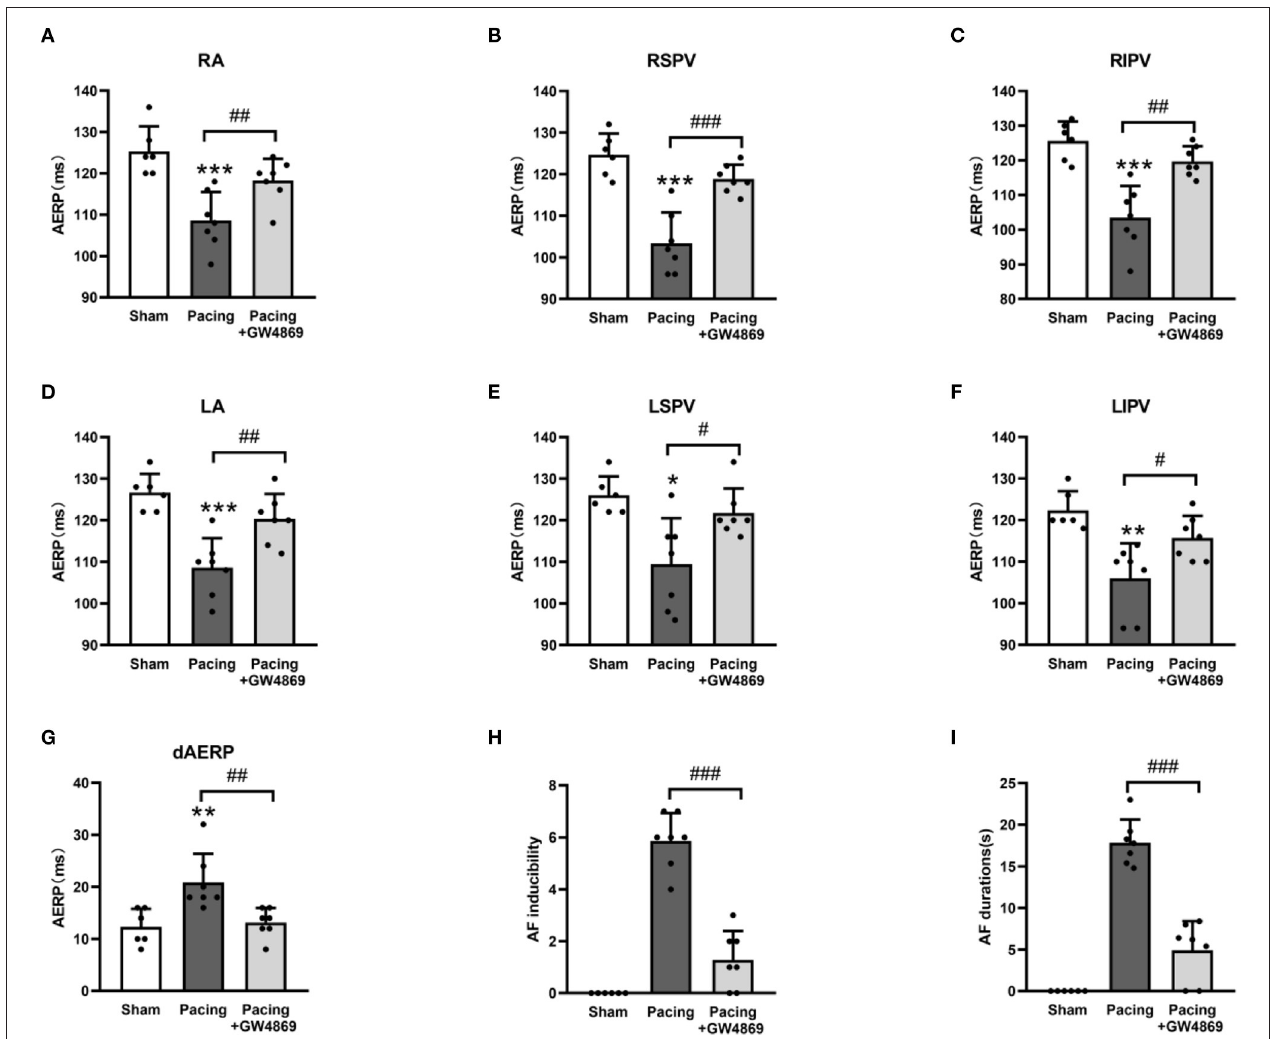
FIGURE 4 | Electrical remodeling in a canine model of AF. (A–F) Differences in AERPs at the RA, RSPV, RIPV, LA, LSPV, and LIPV ( n = 6 for the sham group and n = 7 for the pacing and GW4869 groups). (G) Difference in the dAERP ( n = 6 for the sham group and n = 7 for the pacing and GW4869 groups). (H) Difference in AF inducibility, shown by the number of episodes ( n = 6 for the sham group and n = 7 for the pacing and GW4869 groups). (I) Difference in mean AF durations ( n = 6 for the sham group and n = 7 for the pacing and GW4869 groups). * P < 0.05, ** P < 0.01, *** P < 0.001 vs. the sham group. # P < 0.05, ## P < 0.01, ### P < 0.001 vs. the pacing group. AERP, atrial effective refractory period; dAERP, dispersion of atrial effective refractory period; RA, right atrium; RSPV, right superior pulmonary vein; RIPV, right inferior pulmonary vein; LA, left atrium; LSPV, left superior pulmonary vein; LIPV, left inferior pulmonary vein; AF, atrial fibrillation.